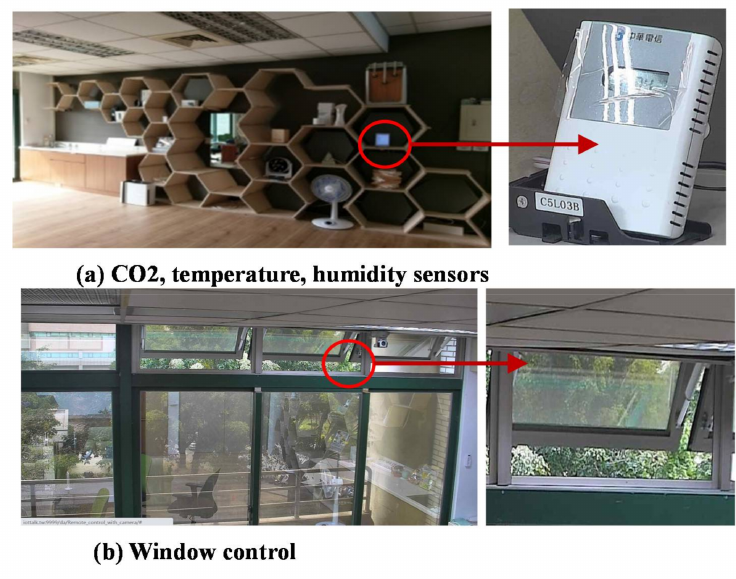
Figure 16. The mutual-test for window